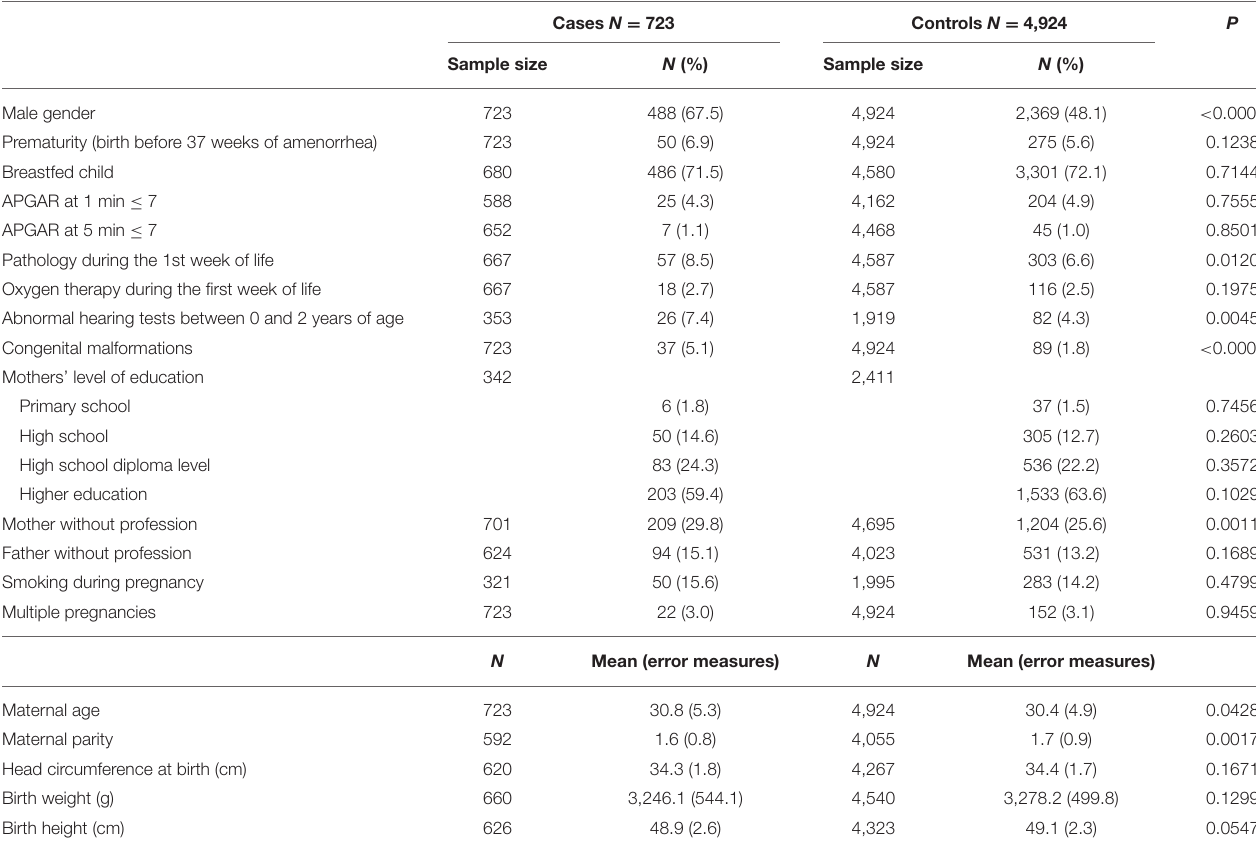
TABLE 2 | Characteristics of the case and control